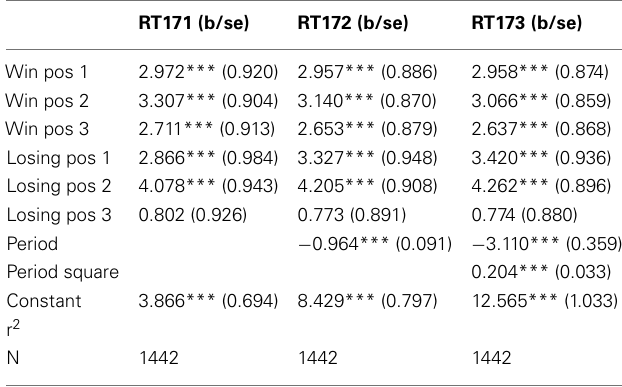
Table 3 | Response time in G(17, 4): panel data